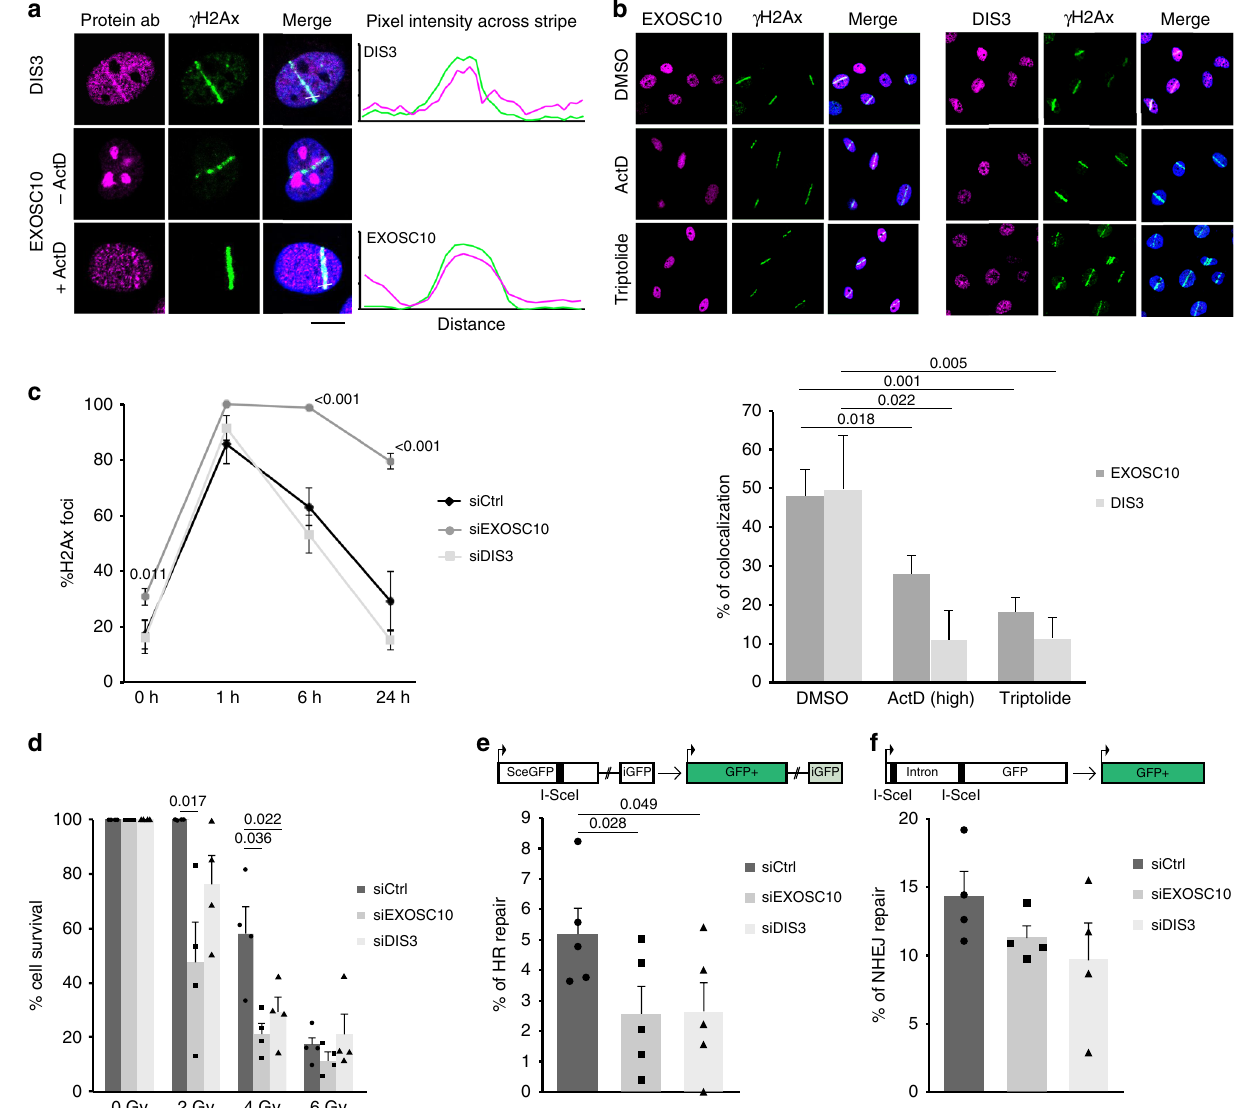
Fig. 1 The exosome is recruited to DSBs and is necessary for HR. a HeLa cells were co-stained with antibodies against either EXOSC10 or DIS3 and γ H2AX 30 min after UV laser micro-irradiation. In some experiments, the cells were treated with Actinomycin D at low concentration (40 nM) for 1 h prior to irradiation and immunostaining to inhibit RNA polymerase I. Scale bar: 10 μ m. b UV laser micro-irradiation experiments were carried out as in a , but the cells were treated with either 8 µ M Actinomycin D for 1 h or 10 µ M Triptolide for 30 min prior to irradiation to inhibit RNAPII. Control cells were treated with DMSO and Actinomycin D (40 nM) to facilitate the imaging of irradiated stripes. The plot shows the percentage of γ H2AX-positive stripes co-stained with antibodies against EXOSC10 or DIS3 in each condition. Statistical testing was done using a Mann – Whitney ’ s test and signi fi cant p -values are shown. At least 40 cells were analysed in each condition (from three independent siEXOSC10 experiments and two independent siDIS3 experiments). c Cells were transfected with either siCtrl, siEXOSC10 or siDIS3, irradiated 48 h after transfection with ionizing radiation (5 Gy), and fi xed at different time-points. The percentage of cells that showed γ H2AX-positive foci were quanti fi ed. The statistical signi fi cance was tested as in b ( n = 3 independent experiments). d Clonogenic assay with 0, 2, 4, and 6 Gy after EXOSC10 and DIS3 knock-down. The histogram shows cell survival 7 days after irradiation. p -values were calculated using a paired student t -test (n = 4). e , f U2OS-DR-GFP or U2OS-EJ5-GFP cells were transfected with either siCtrl, siEXOSC10 or siDIS3 and with a plasmid for I-SceI expression. GFP expression was quanti fi ed by fl ow cytometry and the relative repair ef fi ciencies were calculated. The histograms show the average percentage of GFP-positive cells (% of HR repair in e and % of NHEJ repair in f ) ( n = 5 and n = 4 independent experiments in e and f , respectively). p -values were calculated using a two-tailed Student ’ s t -test. Error bars show s.e.m. Source data for Figs. 1b – f are provided